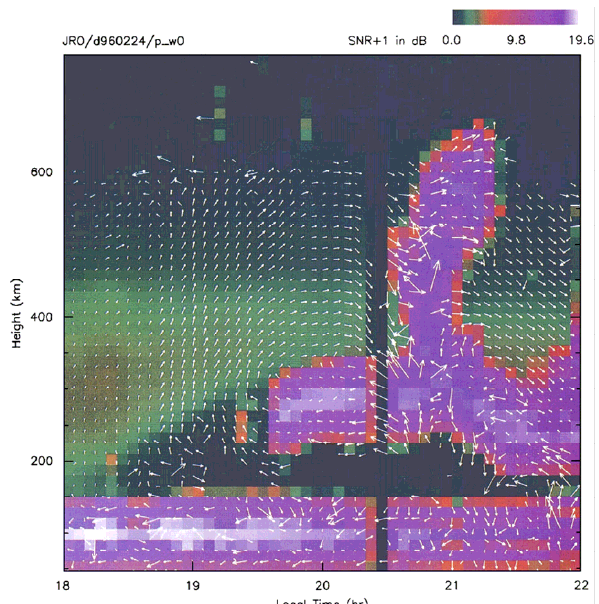
Figure 18. RTI plot showing Spread F echoes (purple color), electron density (greenish tones) and vector drifts. Note the very clean vector drifts in the F region. The main features of this image is the existence of a vortex at the bottom of the F region, with westward drifts in the lower side, right before the initiation of bottom-type Spread F echoes (after Kudeki and Bhattacharyya, 1999).